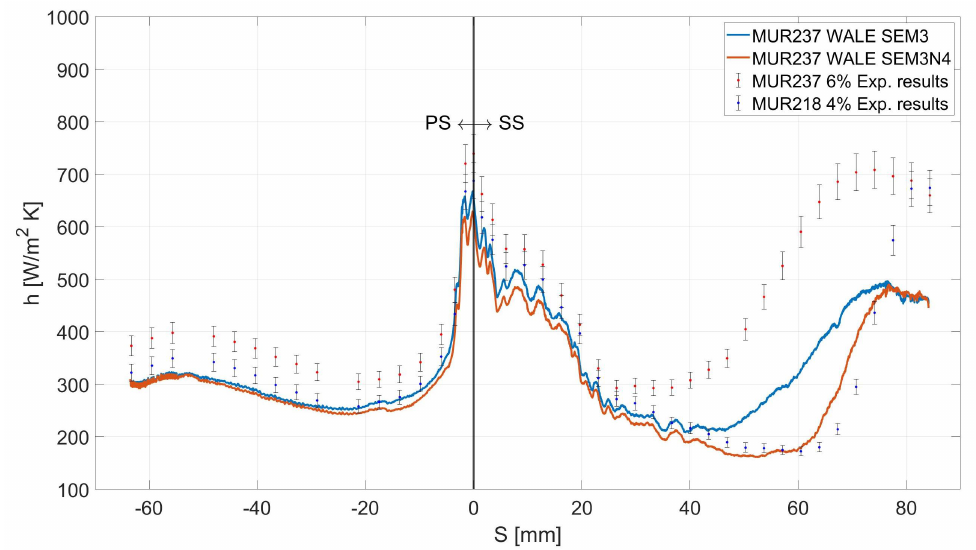
Figure 7. Influence of the number of eddies: convective heat transfer coefficient.